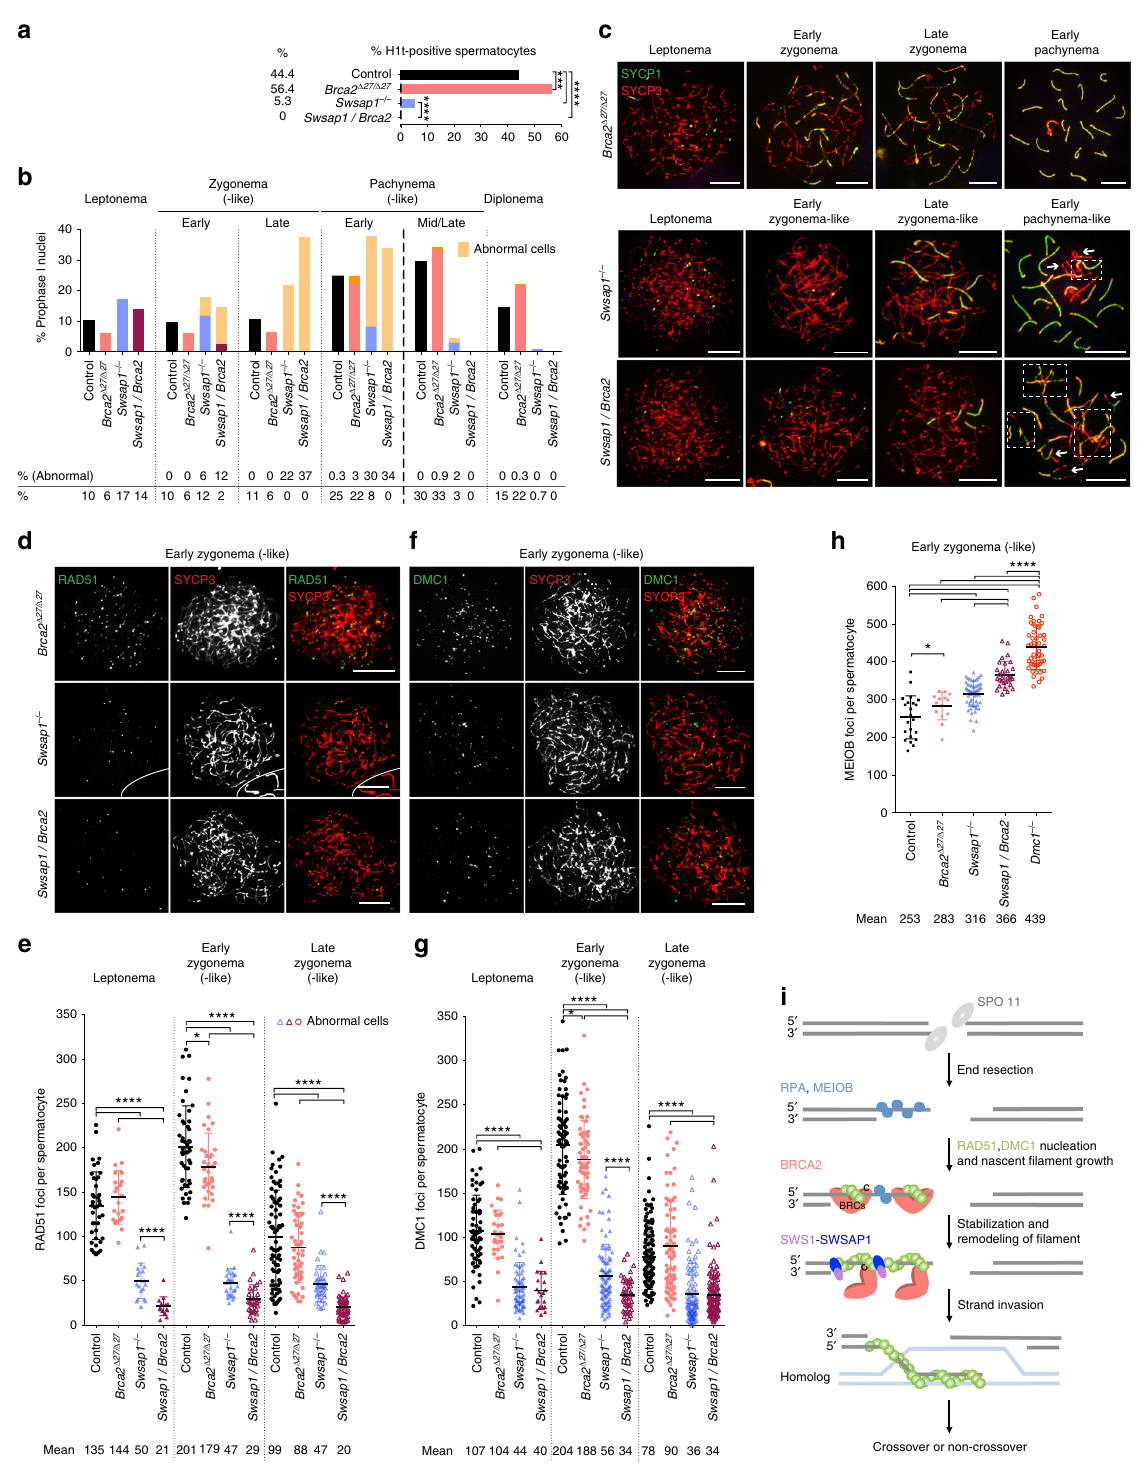
Oocyte chromosome spreads . Prenatal ovaries were collected at embryonic day 18.5 and processed to obtain oocyte spreads as described 57 with some modi fi ca- tions. Brie fl y, ovaries were placed in a 1.5ml Eppendorf tube containing 0.7ml isolation medium (TIM: 104 mM NaCl, 45 mM KCl, 1.2 mM MgSO 4 , 0.6 mM centrifuging for 3 min at 400 g and discarding the supernatant, 0.5ml of 1mg/ml collagenase (Sigma, C0130) in TIM was added to the ovarian fragments and tubes were incubated at 37°C for 1 h with gentle shaking. Next, careful pipetting up